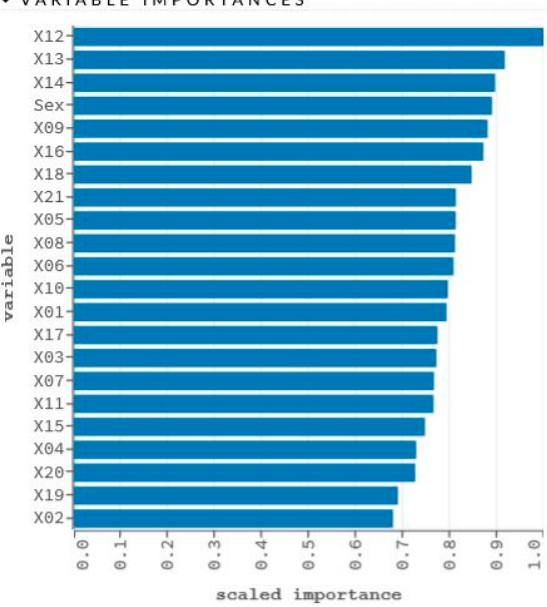
Figure 3. Graphical representation of sensitivity analysis of variables.